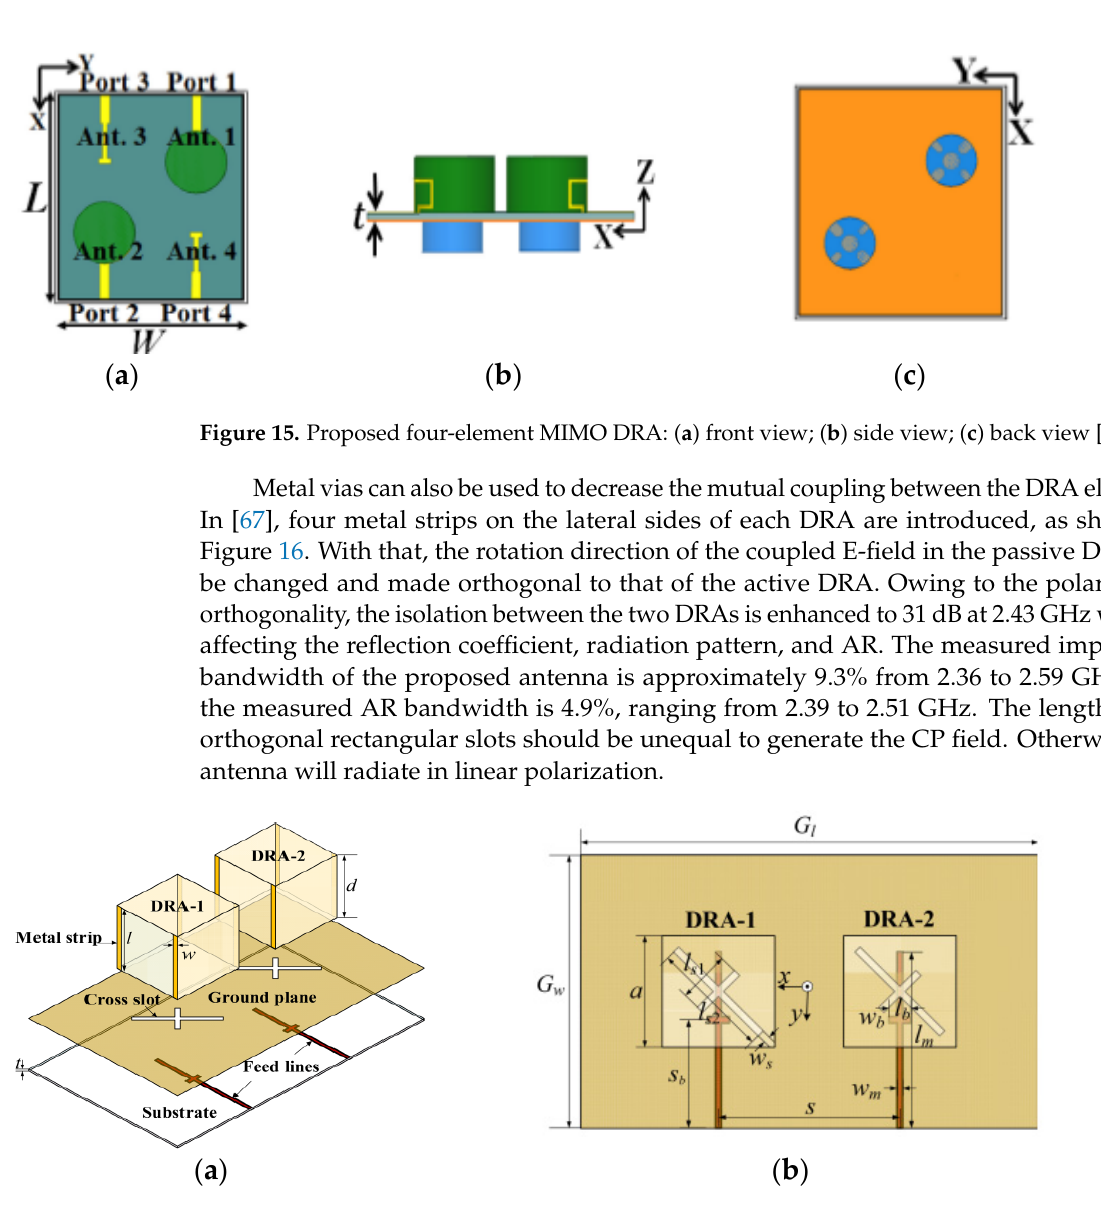
( b ) Figure 14. Proposed MIMO DRA: ( a ) front view; ( b ) fabricated antenna [65]. In [66], an integrated four-element DR based on a MIMO polarization diversity an- tenna is demonstrated for vehicular communication. The proposed antenna comprises two conformal open-loop fed DRA elements (Ant. 1 and Ant. 2), and two microstrip-slot fed DRA elements (Ant. 3 and Ant. 4). As shown in Figure 15, Ant. 1 and Ant. 2 are located at the top of the substrate and placed diagonally. RHCP and LHCP waves are excited in Ant. 1 and Ant. 2, respectively, to establish polarization diversity. Similarly, Ant. 3 and Ant. 4 are positioned at the substrate’s bottom side and generate LHCP and RHCP waves, respectively. Thus, it will create polarization diversity and reduce the interference be- tween the field components. The proposed antenna obtains a 500 MHz measured imped-